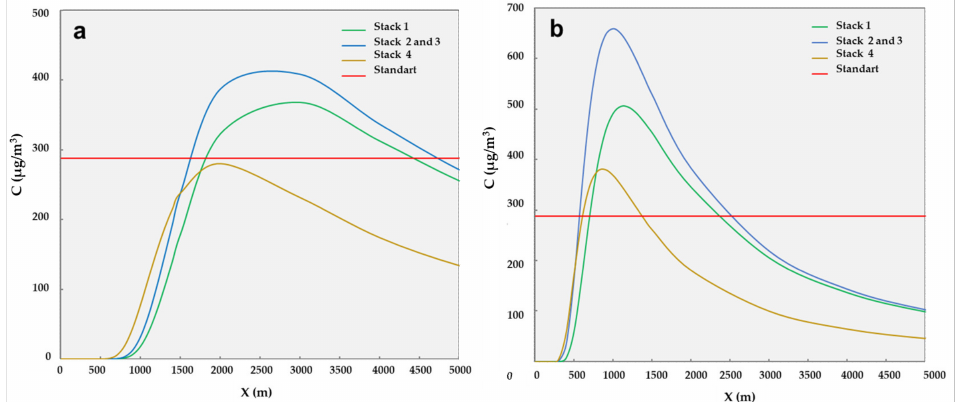
Figure 9. (a ) Scenery 3 and ( b ) scenery 4. Source: Author ´ s